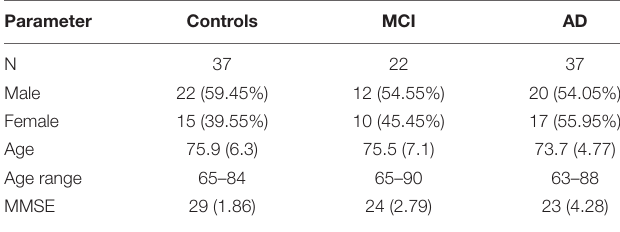
Figure 3 : hand latency, and hand error; Figure 4 ; pupil latency; Figure 5 :